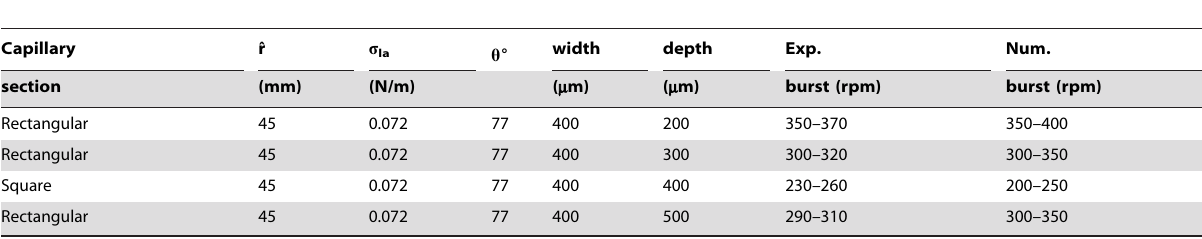
Table 3. A comparison between burst frequencies of square and rectangular capillary